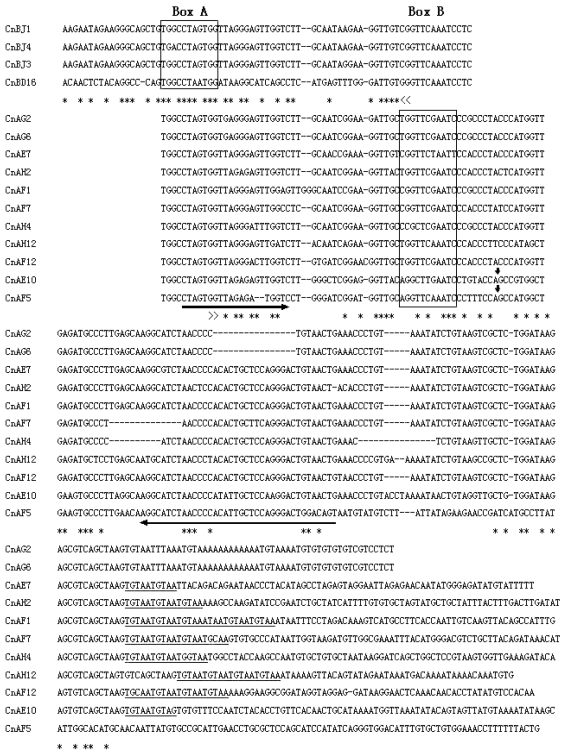
Results of two single-primer PCRs. Alignment of clone sequences from PCR products that were obtained using primer B (4 upper sequences) or primer A (11 lower sequences). The primer sequences are replaced by the following marks: >>, primer A and <<, primer B. Regions of box A and box B are enclosed by solid lines. Direct repeats are underlined. Asterisks indicate identical nucleotides; dash rules denote gaps; a pair of internal primers used for probe biotinylation is marked with lateral arrows; and the insertion site is shown by vertical arrows. GenBank accession numbers: JQ083287–JQ083297.